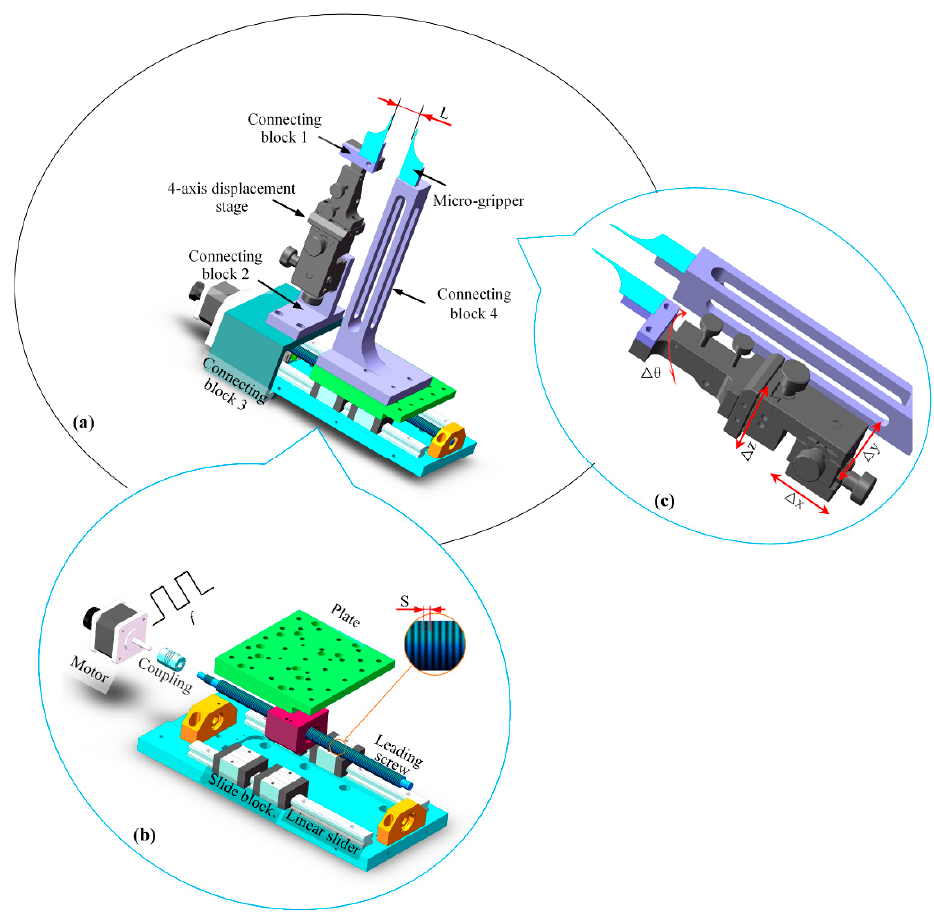
Figure 3. Setup of micro-gripper: ( a ) Three-dimensional model of micro-gripper; ( b ) Local motion system for opening-closing control; ( c ) Local setup of micro-gripper.